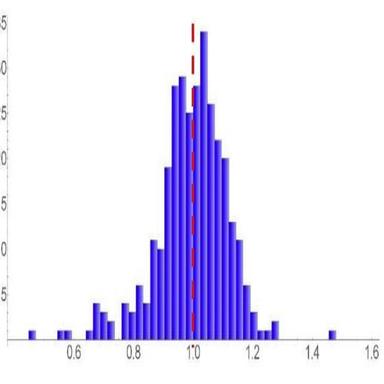
FTP distribution for RHT model.